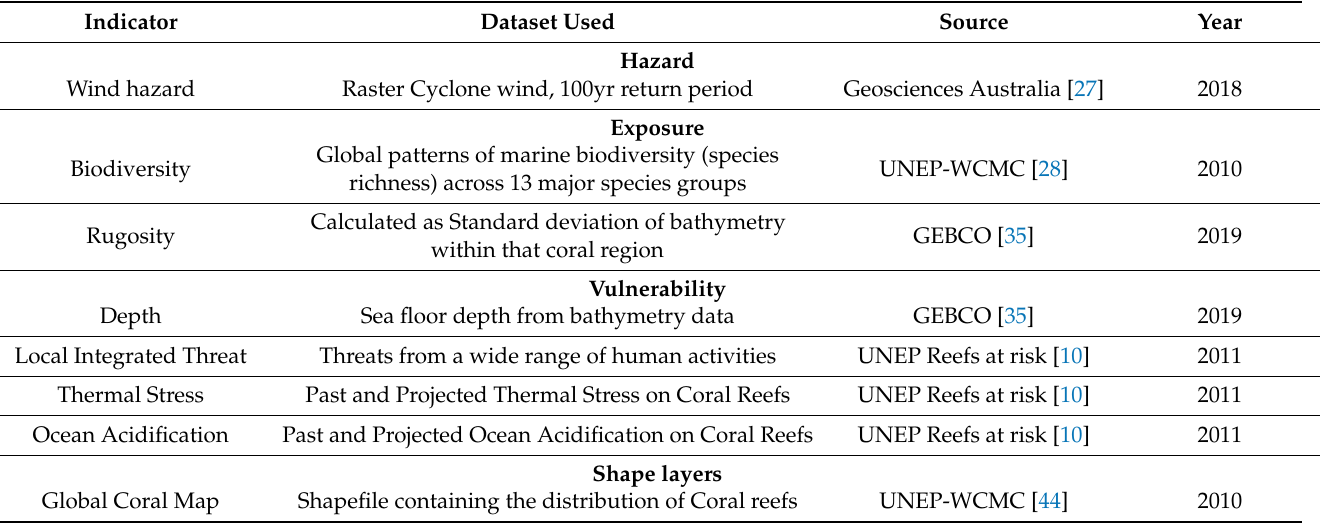
Table 1. Data for TC coral risk assessment. Links are provided for the data sources as well as the year that the dataset was last